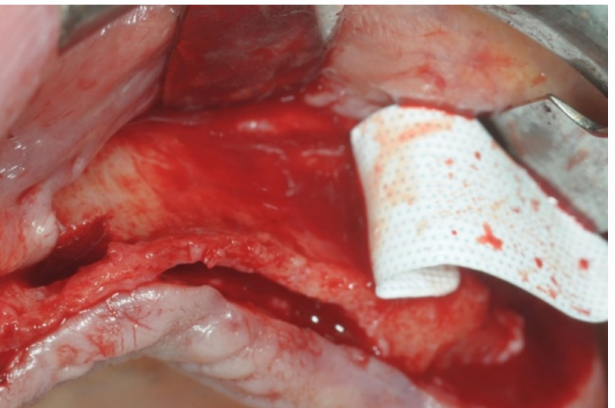
Figure 1. Graft recipient area after bone decorticalization and distal fixation of the non-resorbable barrier.